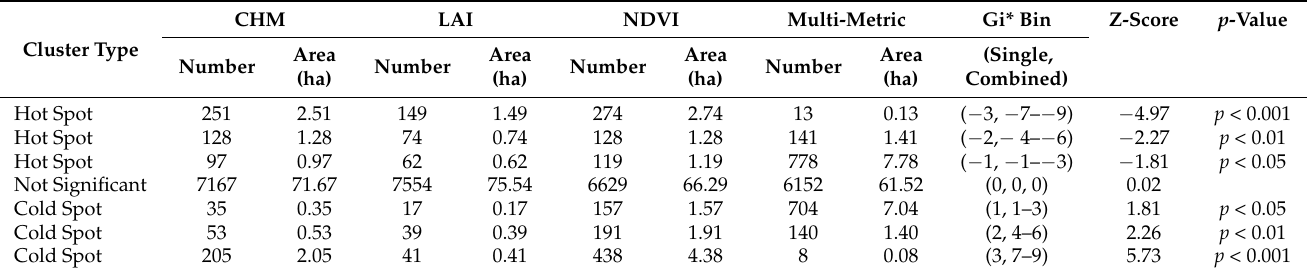
Table 6. Hot spot analysis of vegetation metrics using the Getis–Ord Gi* and corresponding z-scores and p